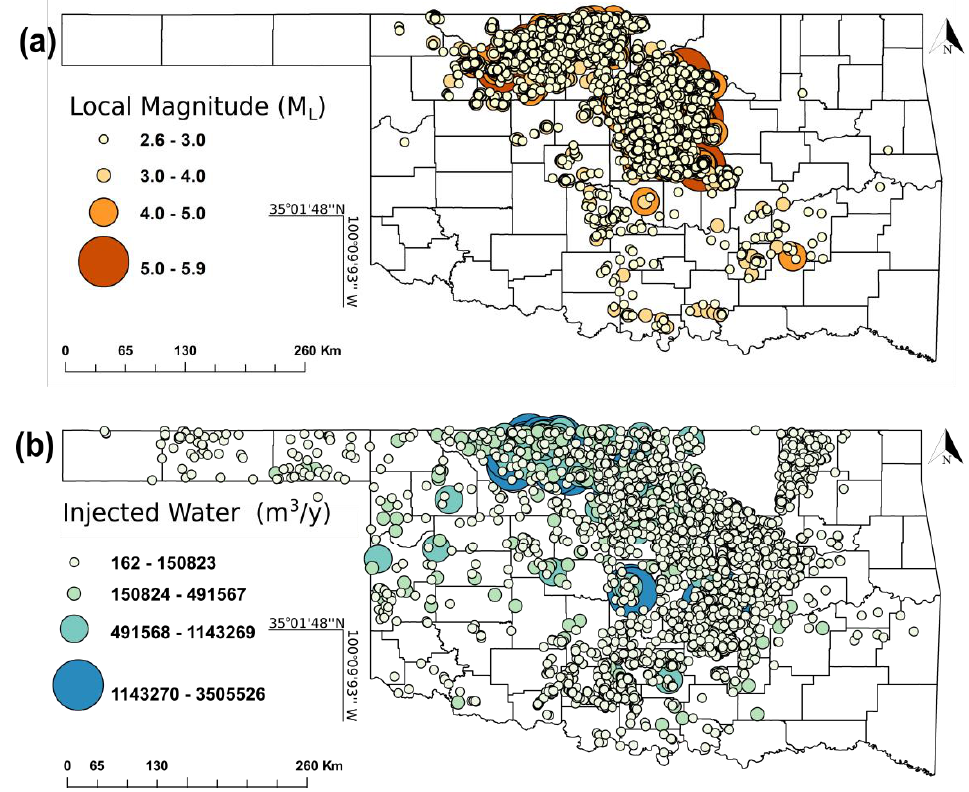
Figure 4. ( a ) Spatial distribution of earthquakes with M L ≥ M C occurred in Oklahoma from 2006 to 2017; ( b ) Spatial distribution of wastewater disposal wells with corresponding IW volume (m 3 /year) operated in 2014.